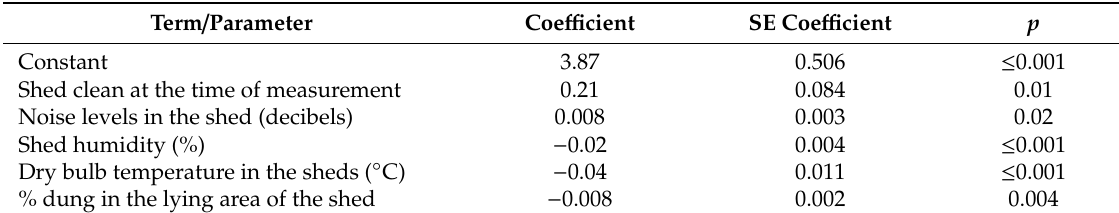
Table 6. Regression analysis of shelter-based measures significantly related ( p < 0.05) to avoidance distance